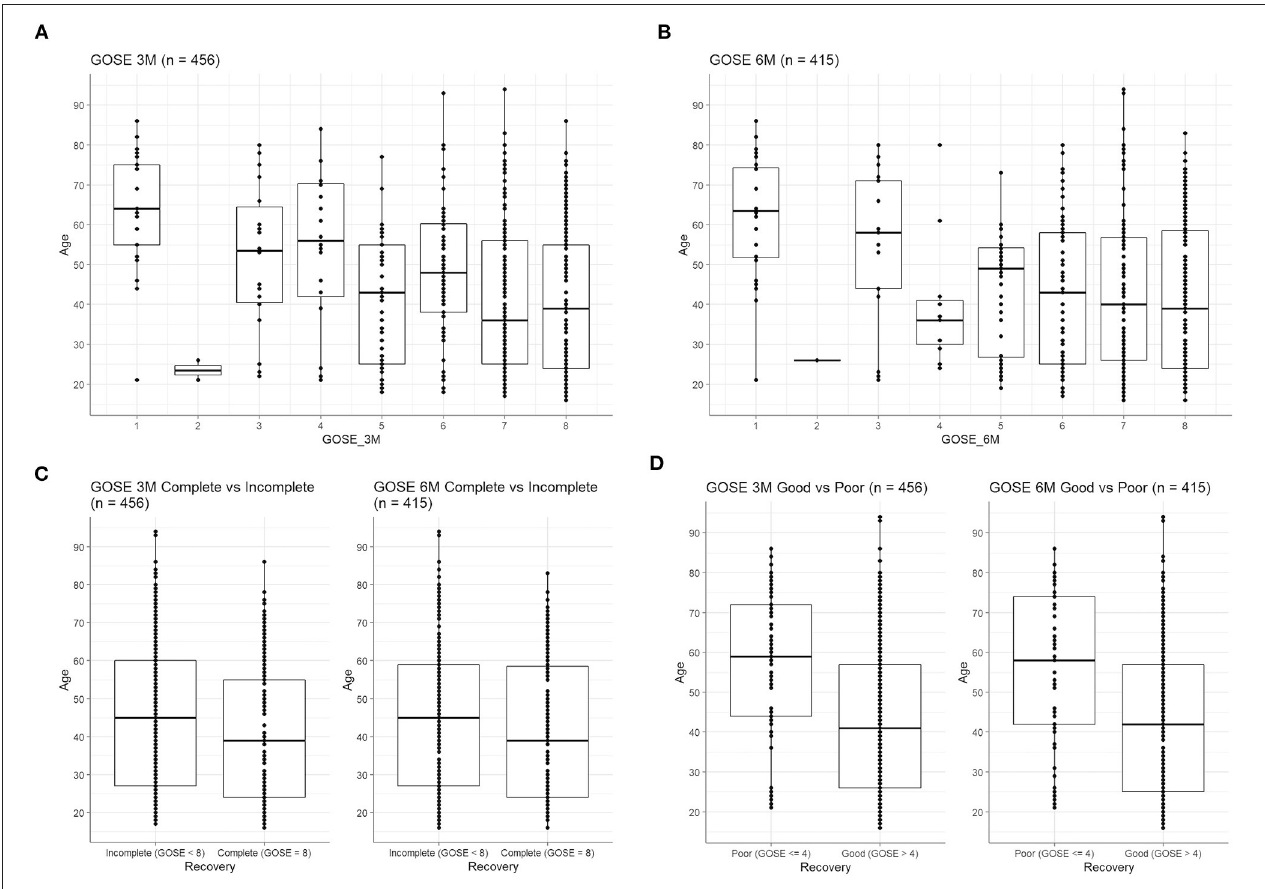
FIGURE 3 | Age correlates with worse outcome on GOS-E. Age differs significantly across the eight levels of the GOS-E at (A) 3 months [ F (7,448) = 8.0, p < 0.001] and (B) 6 months [ F (7,407) = 5.66, p < 0.001]. (C) GOS-E was dichotomized as incomplete recovery (GOS-E score < 8) vs. complete recovery (GOS-E score of 8). Patients with complete recovery were significantly younger, at 3 months (Welch’s t = − 2.34, p = 0.02), but not at 6 months (Welch’s t = − 1.77, p = 0.08). (D) GOS-E was dichotomized as poor recovery (GOS-E score of 4 or below) vs. good recovery (GOS-E score of > 4). Patients with poor recovery were significantly older, at